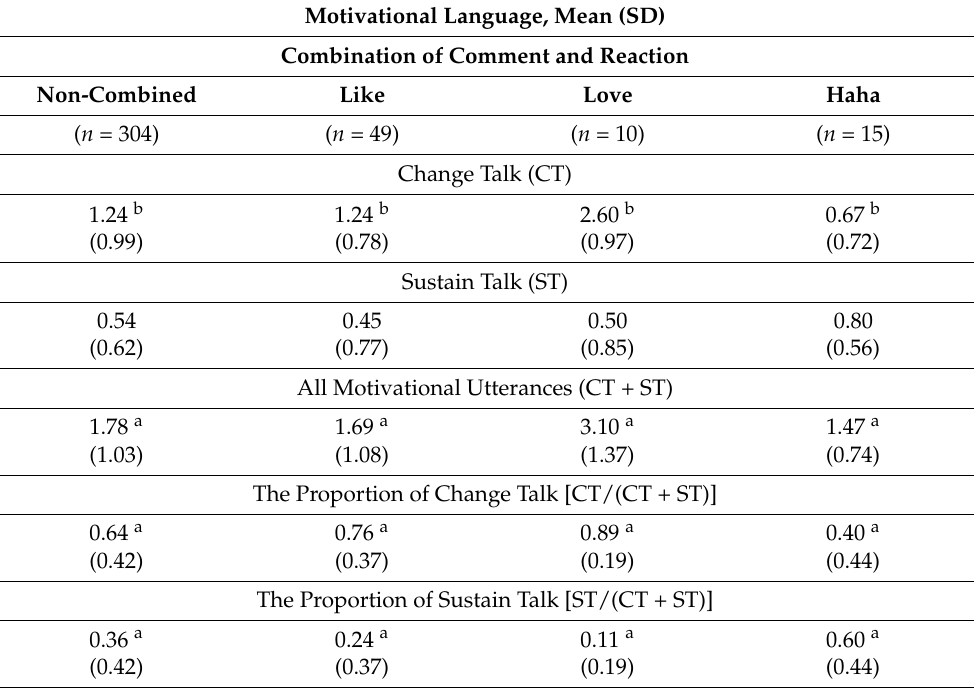
Table 3. The mean and the SD of change talk and sustain talk by combinations with reactions. Motivational Language, Mean